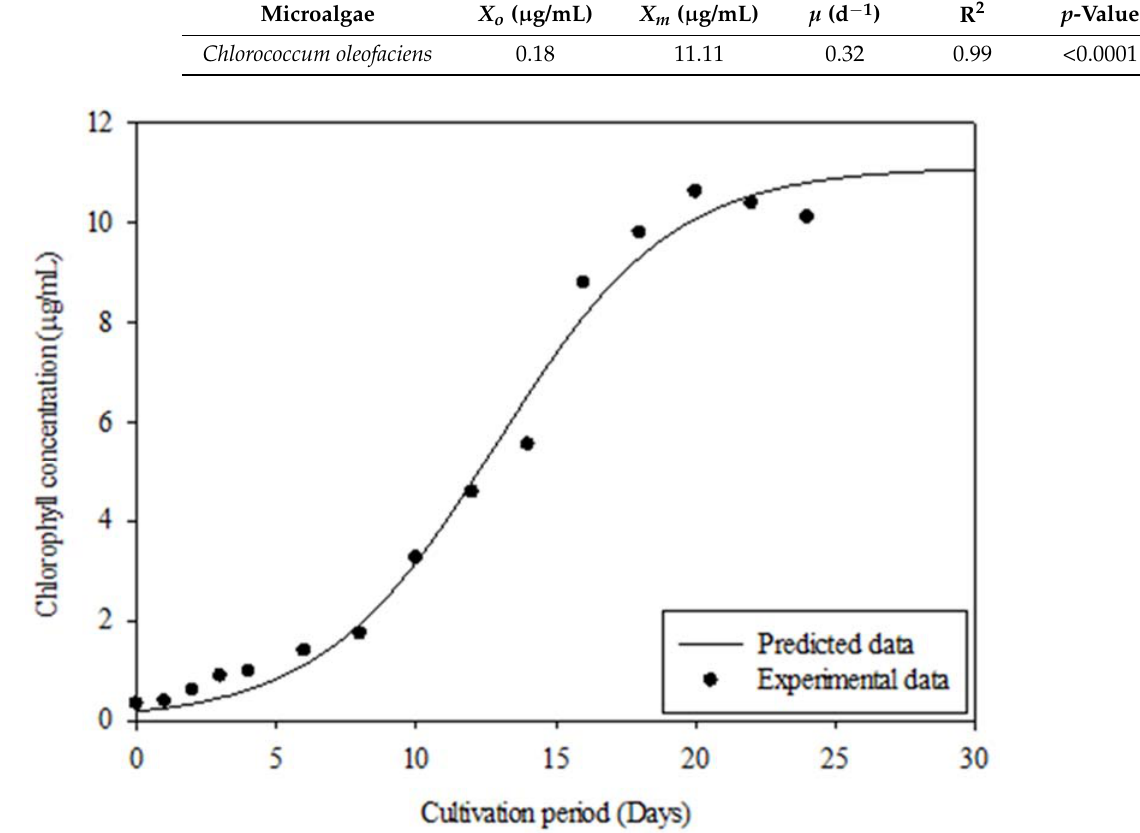
Figure 6. The relative reproductive rates of Chlorococcum oleofaciens in LABT-POME fitted to the normalised logistic model.